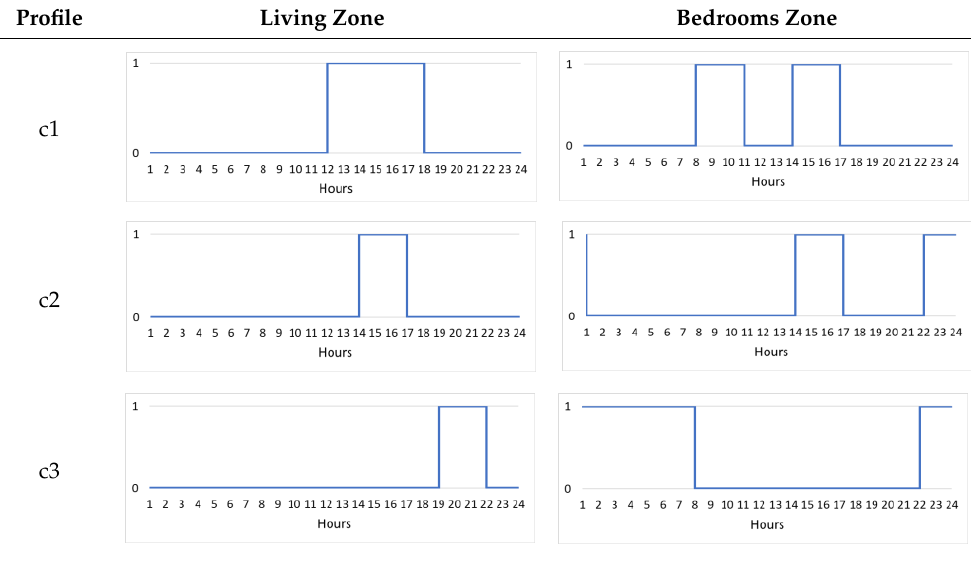
Table 4. Daily cooling schedules (On = 1, Off = 0). Adapted from [33].